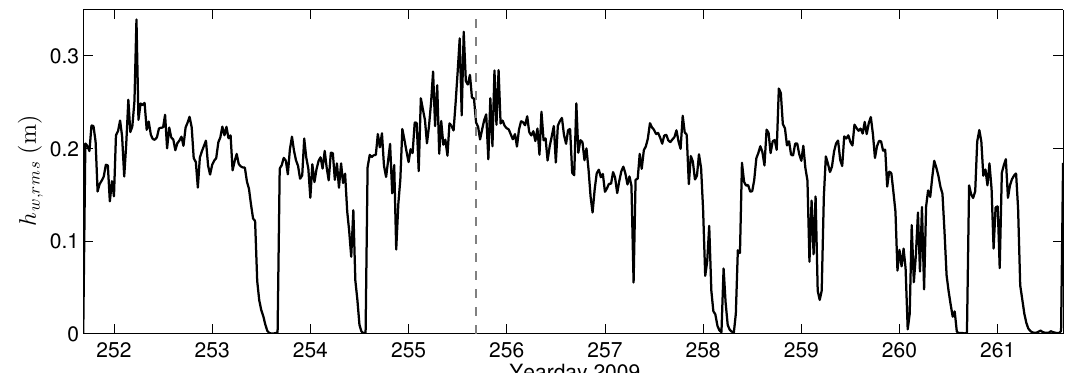
Figure 6. Time series of the modeled root mean squared (RMS) wave height ( h w , rms ) measured at the point indicated by the cross in Figure 4b). The gray dashed line indicates the time point of 4:30 p.m. on 13 September 2009, which corresponds to the time point in Figures 4, 7, and 8a. SSC (mg L −1 ) (a) Modified formula, 04:30 am, 13 Sep.